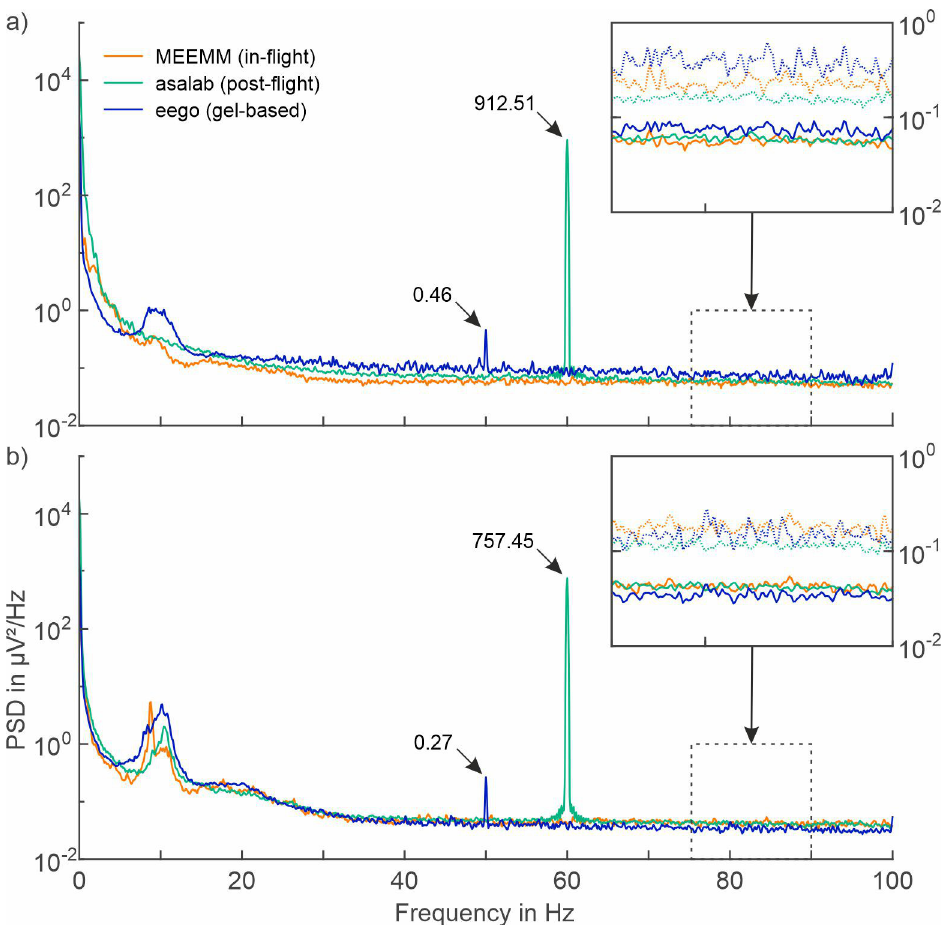
Fig 3. Comparison of power spectral density (PSD) between unshielded and actively shielded EEG recordings. Average PSDs of 30 seconds of resting-state EEG data recorded with unshielded (MEEMM, in-flight), and actively shielded gel-based electrode caps (asalab / eego, ground-level) conditions with a) open eyes, and b) closed eyes of the participants. Solid lines represent mean; dotted lines represent mean + standard deviation.